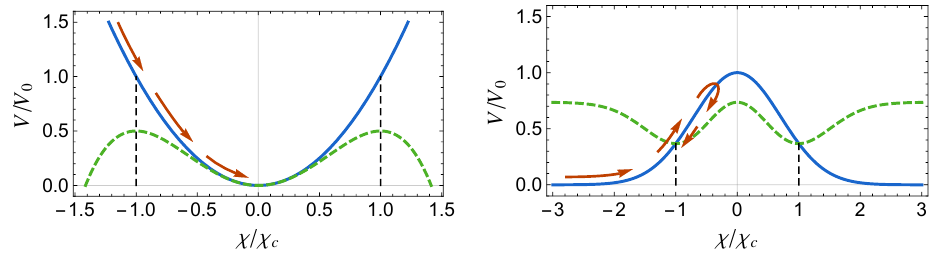
Figure 1. Representation of the possible evolution of the field χ for the quadratic potential ( left panel ) and the Gaussian potential ( right panel ). Notice that—independently of the shape of the potential (blue)—the field χ decays monotonically until it enters the interval [ − χ c , χ c ] . Once inside this interval, the field evolves towards a minimum of the effective potential (green), defined by V ef f , χ = ( 1 − χ 2 / χ 2 c ) V , χ